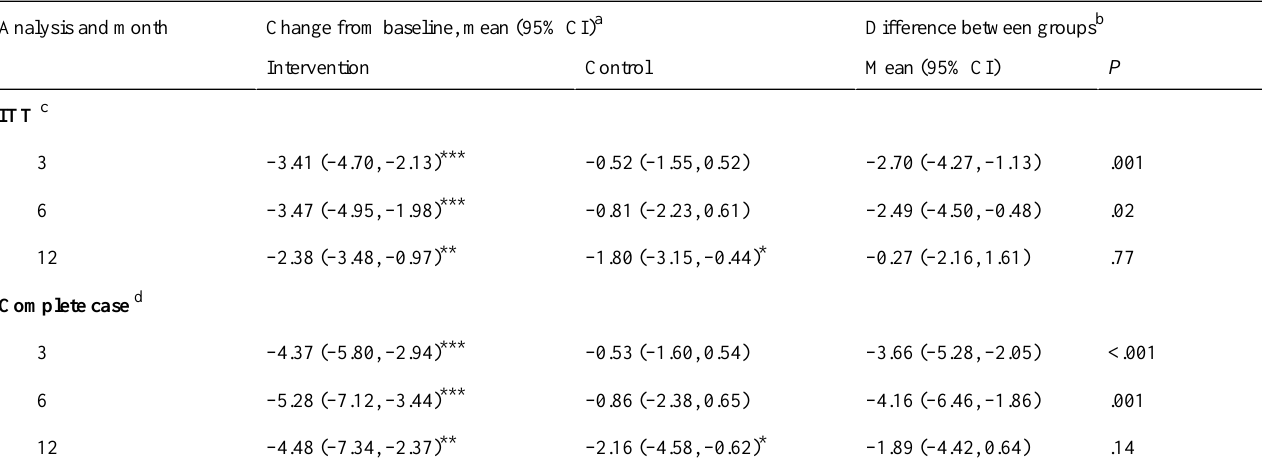
Table 3. Weight (kg) outcome differences between and within study groups from baseline to 3, 6, and 12 months (intention-to-treat [ITT] and complete-case